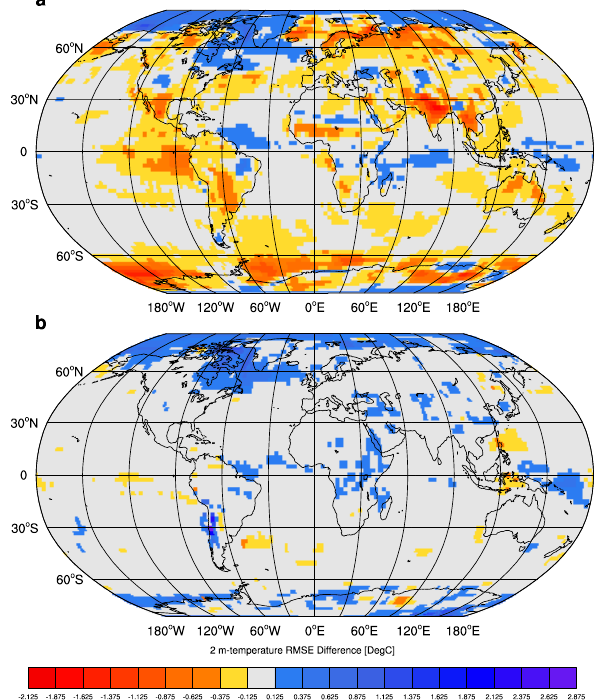
Figure 6. The difference between the 10-year validation period average 2m temperature RMSE of the climatology and the EGA forecaster, (a) EGA with an ensemble that includes eight models, (b) EGA with an ensemble that includes the same eight models and also the climatology of the learning period as an additional model. The results demonstrate that when the ensemble includes the clima- tology, the EGA forecaster is